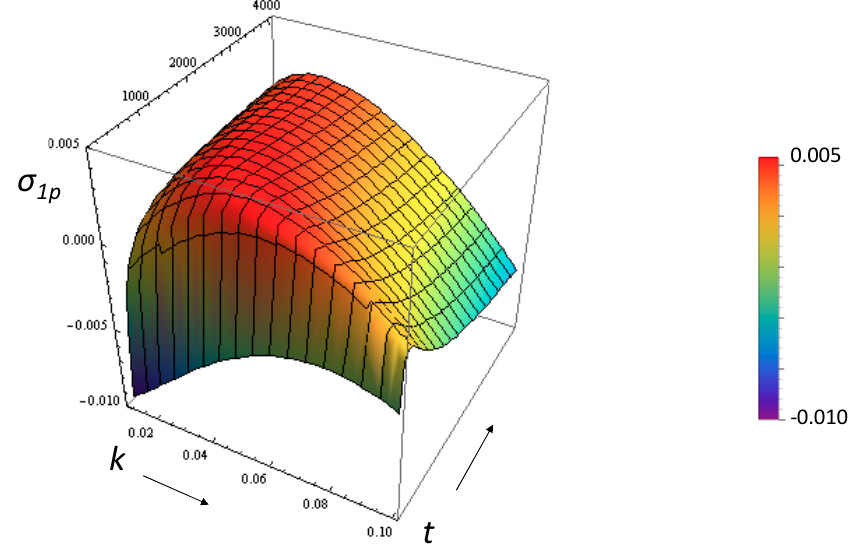
Figure 2. Variation of the growth rate of perturbations with wave number and time for the inert system ((cid:1830)(cid:1853)/(cid:1844)(cid:1853) (cid:2870) = 0) using the dominant mode analysis.